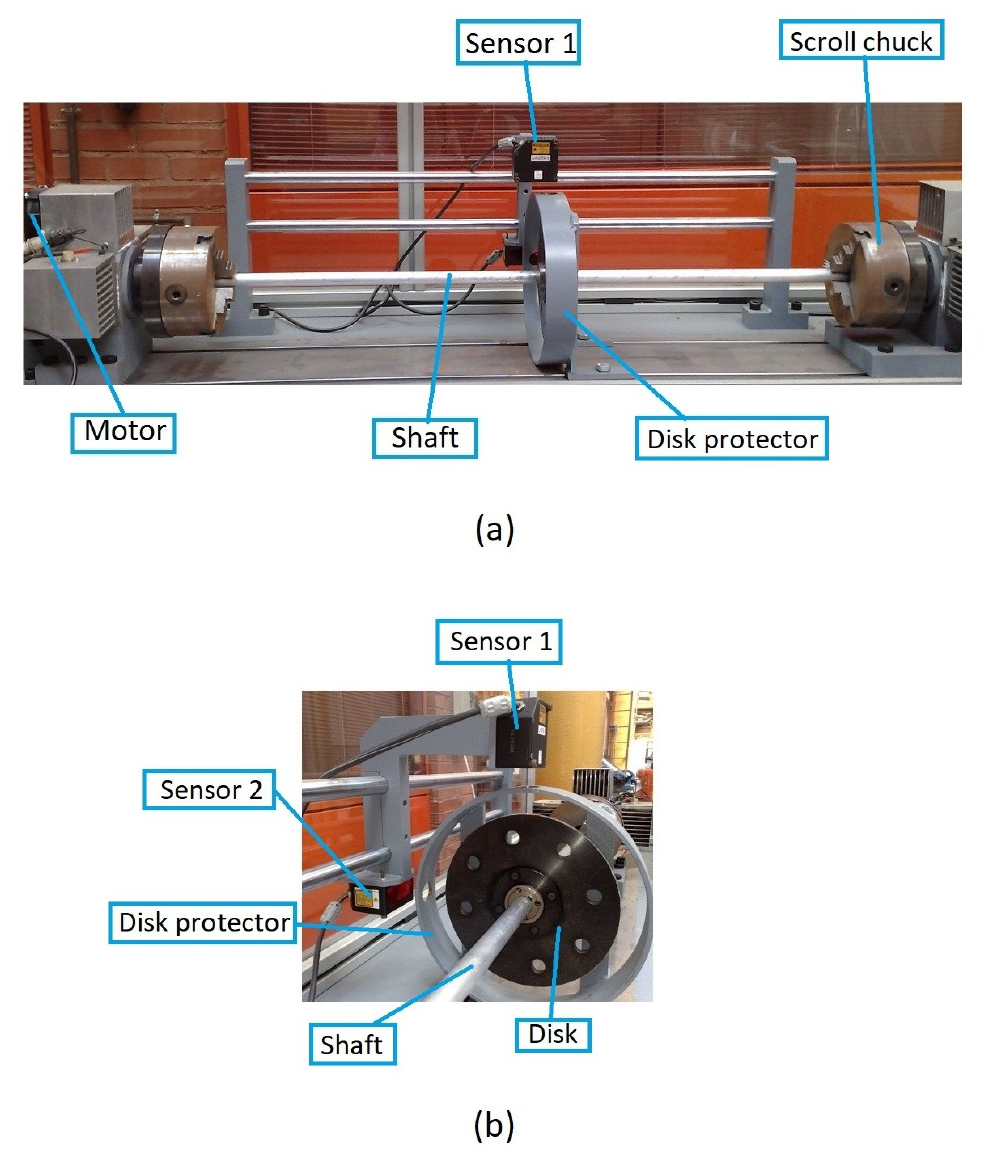
Figure 16. ( a ) Layout of the shaft and ( b ) disk